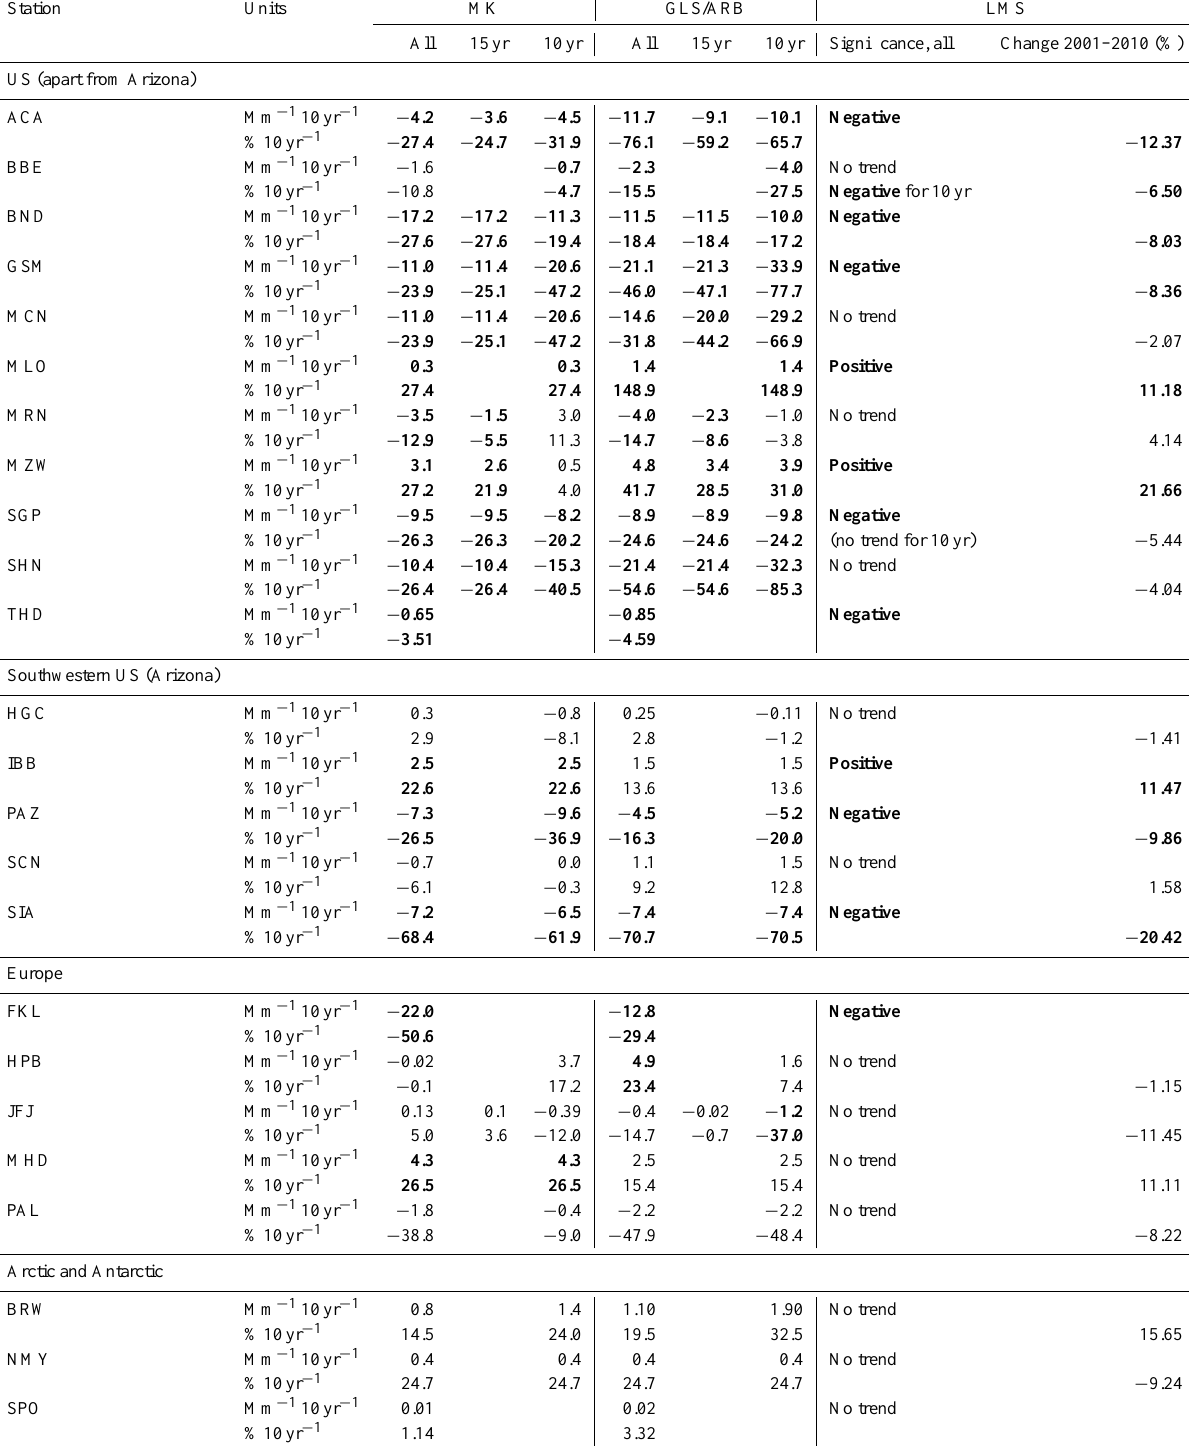
Table 3. Significance and slope of the trends of the scattering coefficient calculated with the MK, GLS/ARB and LMS methods for the entire measured periods (all), and for 15yr and 10yr when possible. The statistically significant trends at 95% confidence level are highlighted in bold. Only the significance of the LMS fits is mentioned for the entire measured periods, since the LMS results deal with the data logarithm; for the 10yr period, the changes in % over the 2001–2010 period were calculated from the LMS slopes in order to allow comparison with the other 10yr